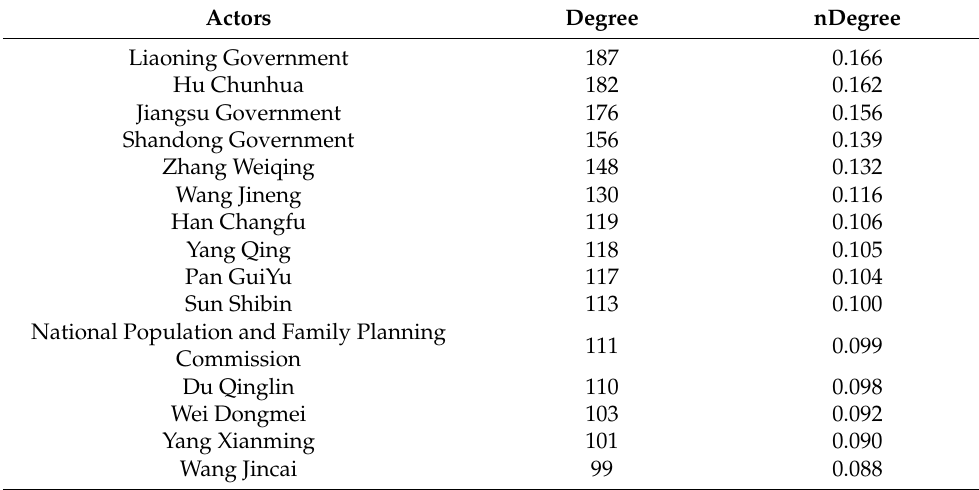
Table 3. Degree centrality analysis of the overall network (2004–2009).